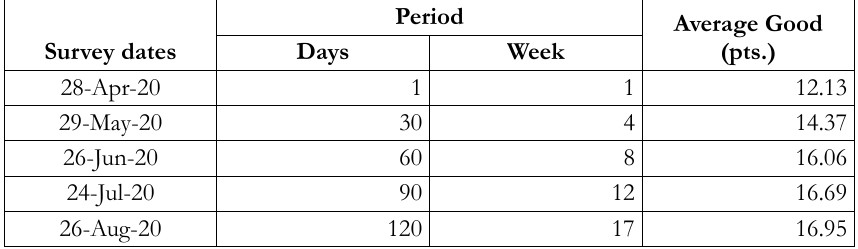
Table 4. Average-Good. Own source